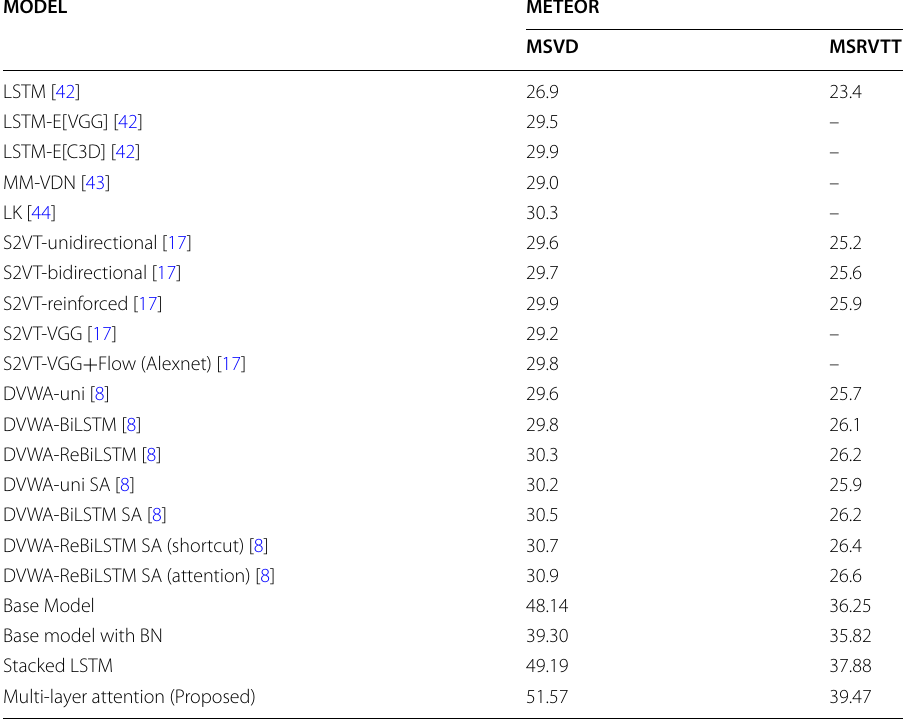
Table 2 Performance comparison of METEOR score with state-of-art-methods MODEL METEOR MSVD